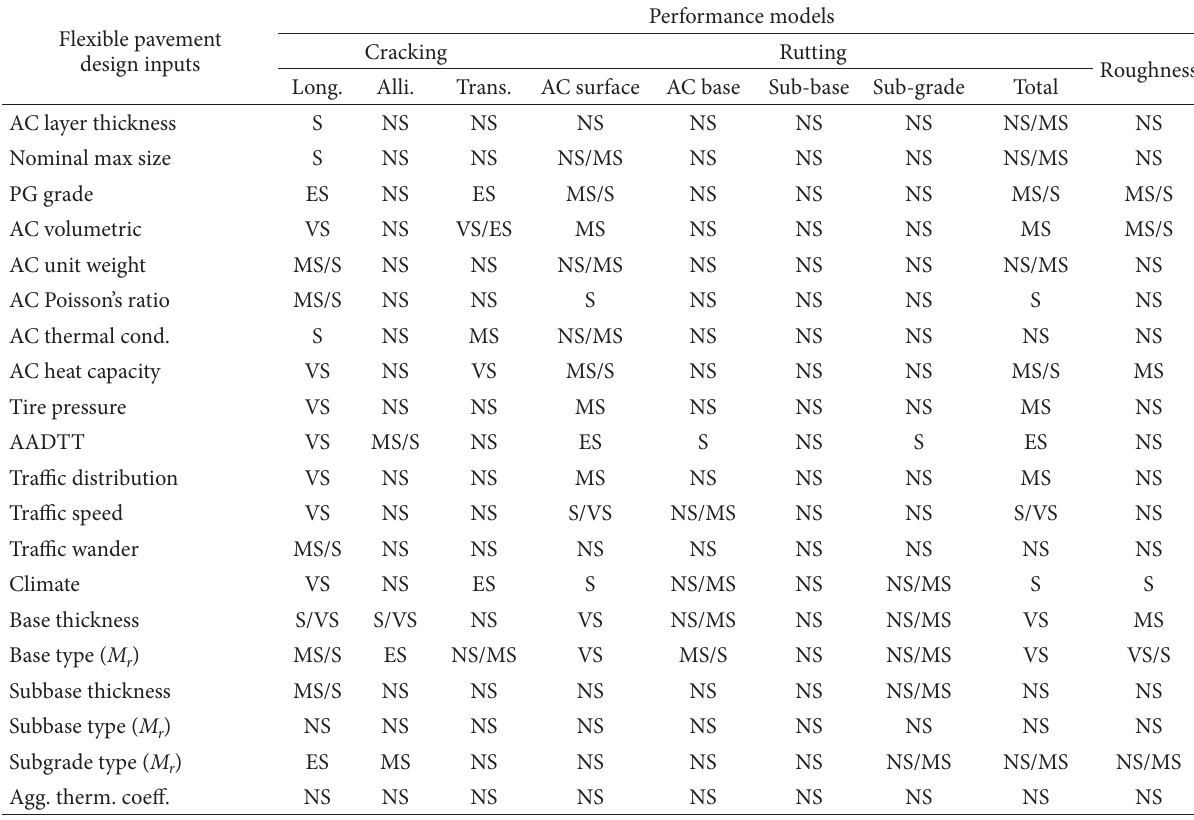
Table 2. Summary of results of sensitivity analyses for flexible pavements Flexible pavement design inputs